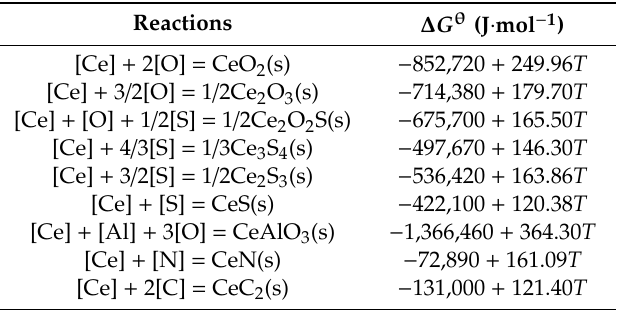
Table 2. Possible chemical reactions and their ∆ G θ